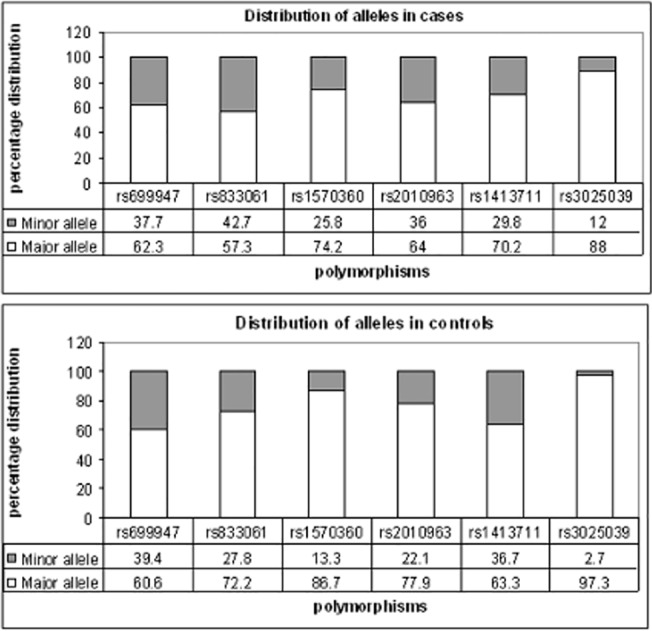
Allelic frequencies in cases and controls.